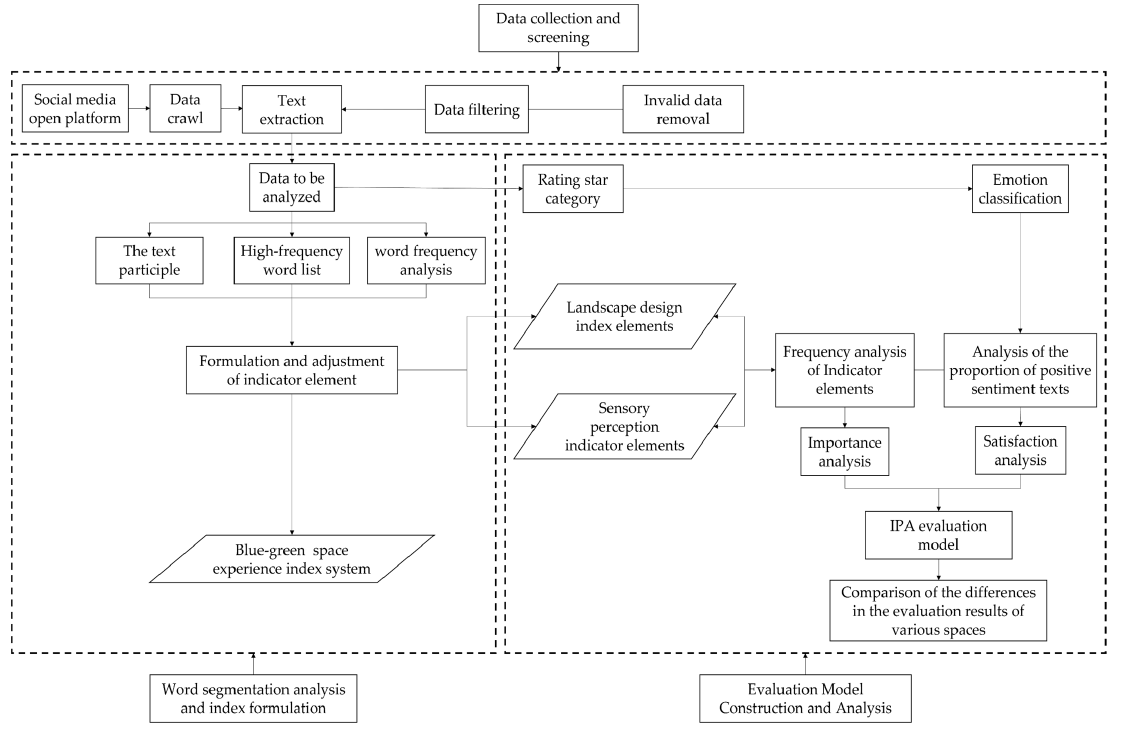
Figure 2. Evaluation framework for the study of landscape satisfaction of typical blue–green spaces in Beijing.